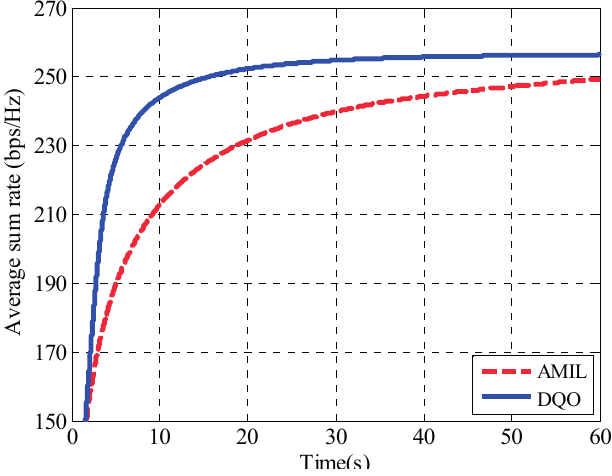
Figure 10. Convergence curves of the average sum rate in (10 × 10, 1) 19